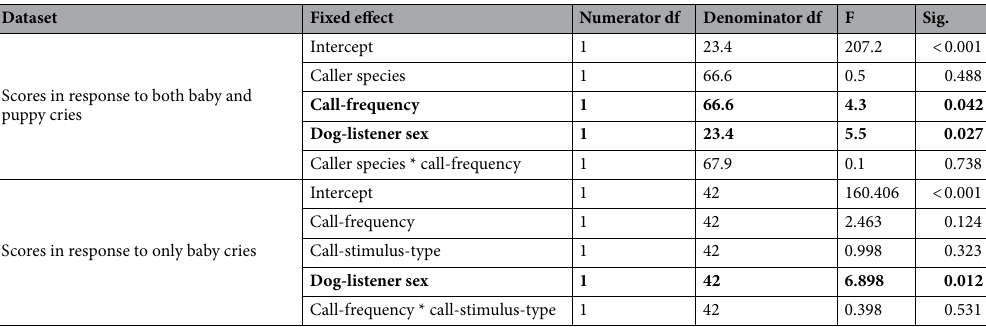
Table 1. Linear mixed model results for response scores for (a) both puppy and baby trials together and (b) baby cry trials only. Significant results (p < 0.05) are marked in bold.